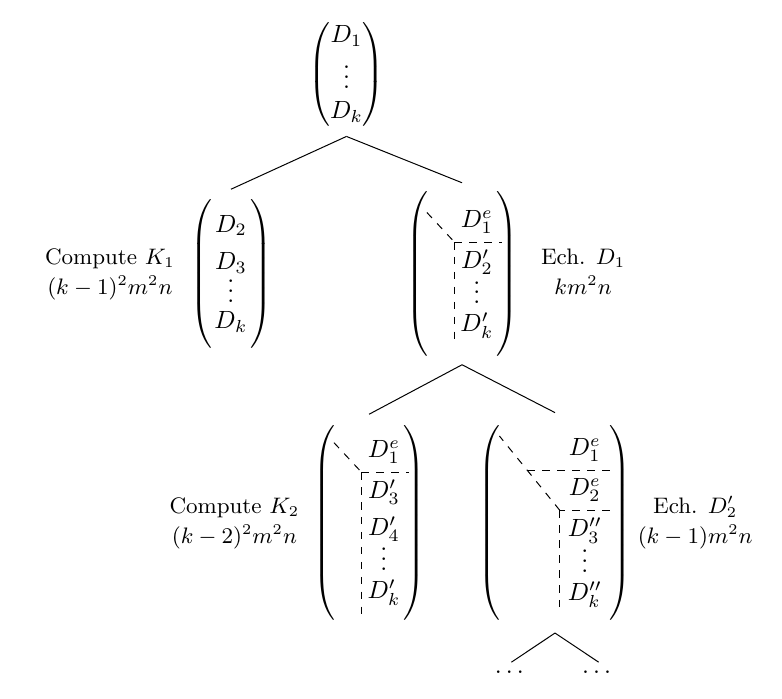
Figure 6: Efficient computation of the